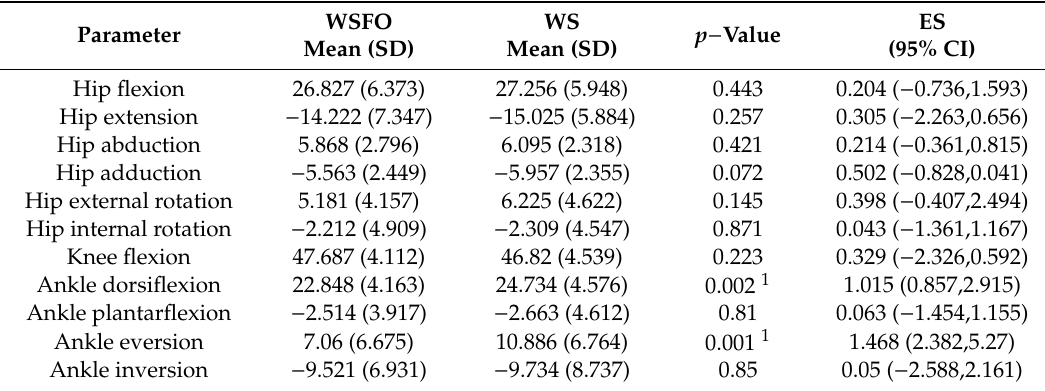
Table 1. Peak joint angles between two walking conditions during stance ( ◦ ).